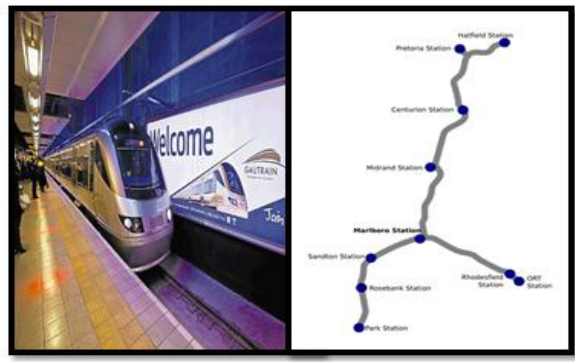
Figure 1: The Gautrain and its routes The railway network of the Gautrain runs through the Gauteng province (Figure 3), linking three metropolitan cities: the City of Johannesburg (COJ), the City of Tshwane (COT) and Ekurhuleni Metropolitan Municipality (EMM). To date there is little known about the travelling behaviours and patterns of the Gautrain commuters, hence the study assesses the feasibility of using modern technologies as tools to create origin-destination models for Gautrain commuters. This approach is being tried and tested as there is evidence of insufficient spatiotemporal data obtained for this project.